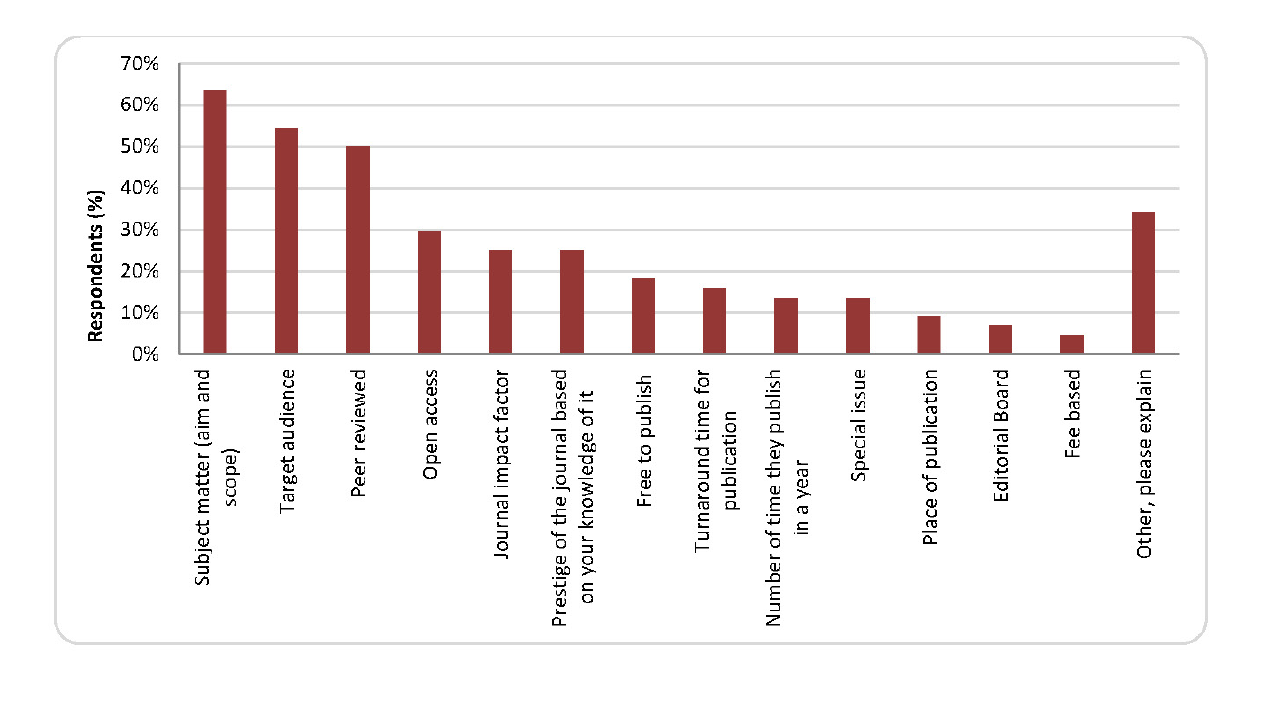
Figure 1 Criteria for choosing a journal for publication among nursing faculty and